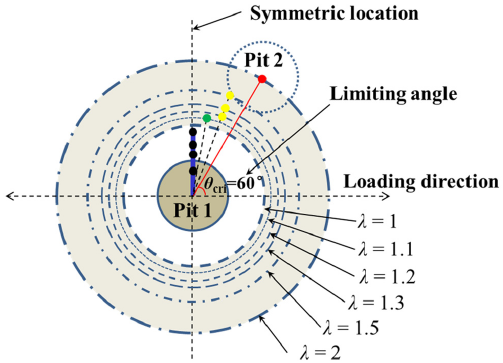
Figure 10. Schematic drawing showing the relationship of θ cri with λ , reflecting the dependence of the asymmetry feature on the spacing between two pits. For clarity, the locations of Pit 2 are presented with colored dots. The black, green, yellow, and red dots correspond to 90°, 80°, 70° and 60°, respectively.